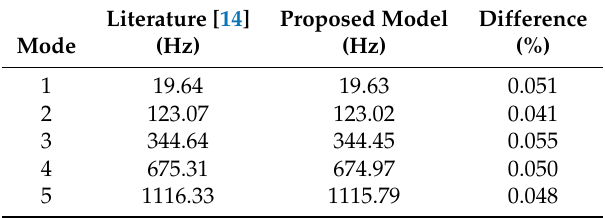
Table 1. Comparison of analytical results: clamped-free (Case